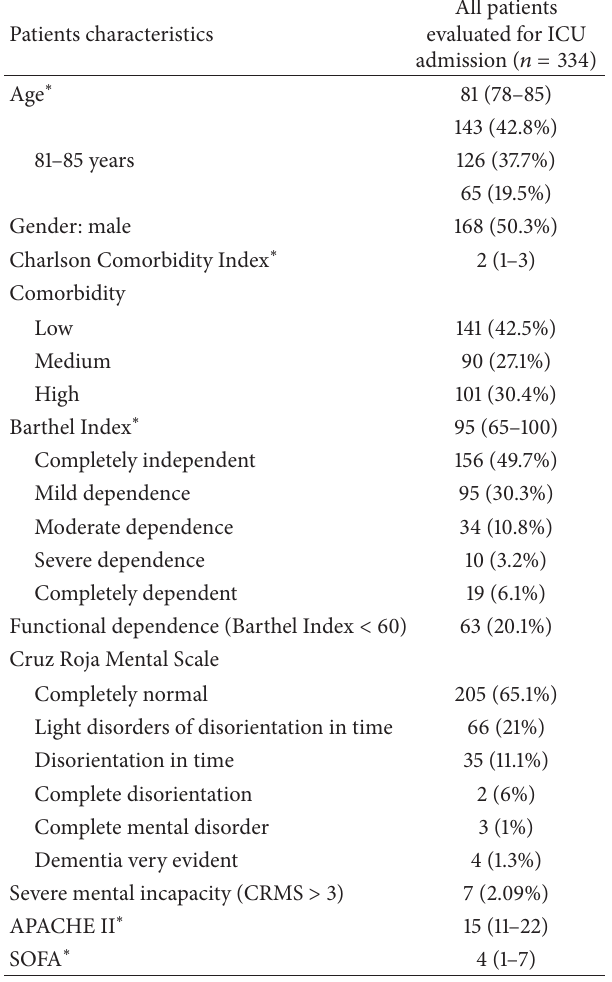
Table 1: Clinical characteristics of the patients at first ICU.